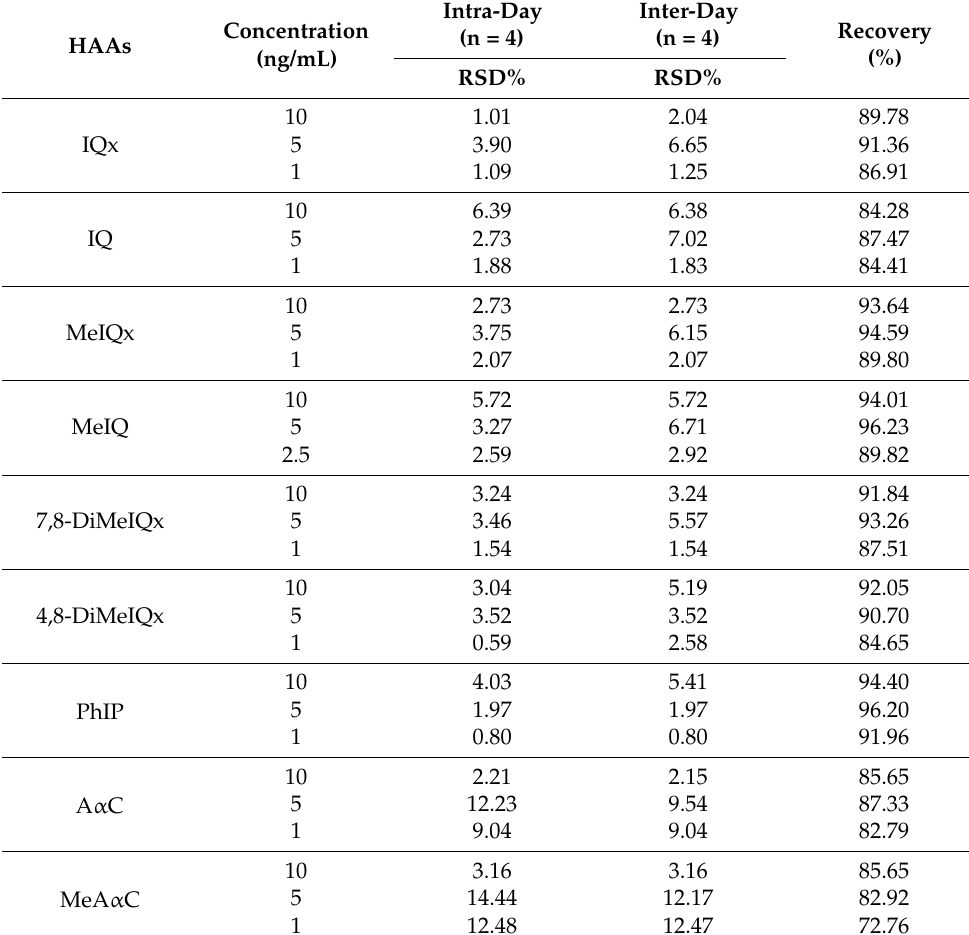
Table 5. The relative standard deviation (RSD%) and recovery (%) of different heterocyclic aromatic amines in raw milk spiked at three different